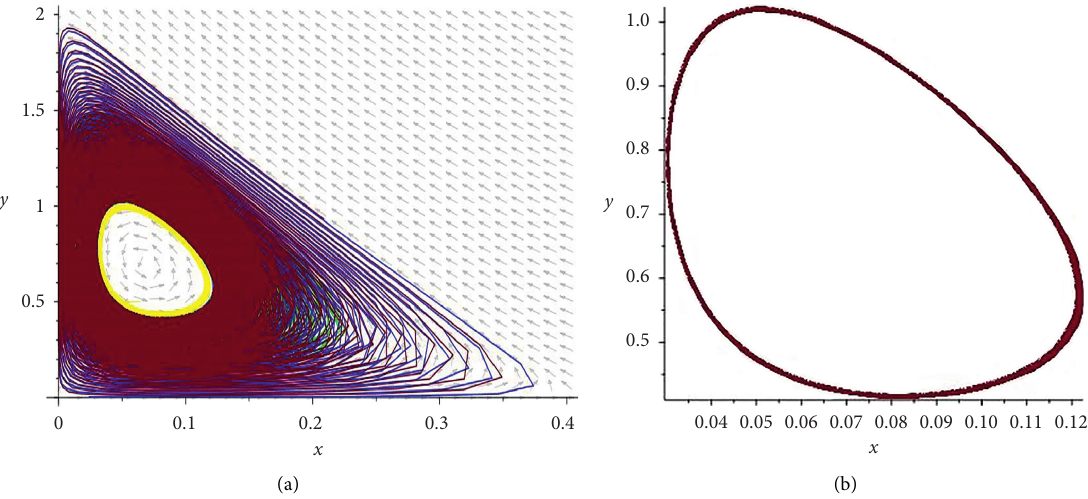
Figure 5: Figures in Example 2 with d � 2 . 09. (a) Phase diagrams around an unstable focus. (b) Enlarged phase diagrams: limit cycle.